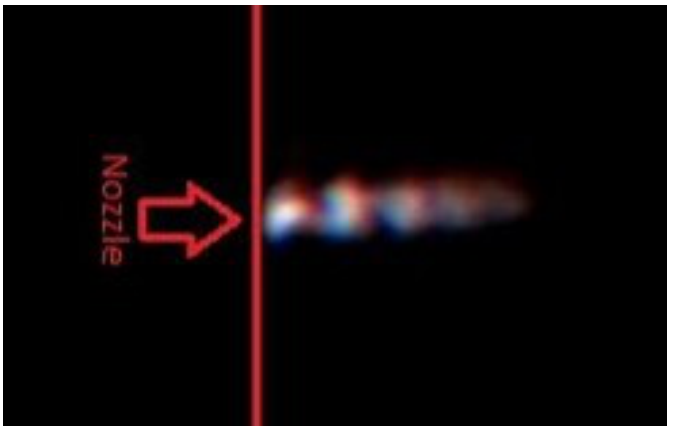
Figure 13. Schlieren photograph of ambient temperature air passing through the 30 degree half-angle nozzle vented directly to the laboratory, with an upstream stagnation pressure of approximately 55 psig. An overexpanded diamond shock pattern is visible which is evidence of supersonic flow in the diverging section of the